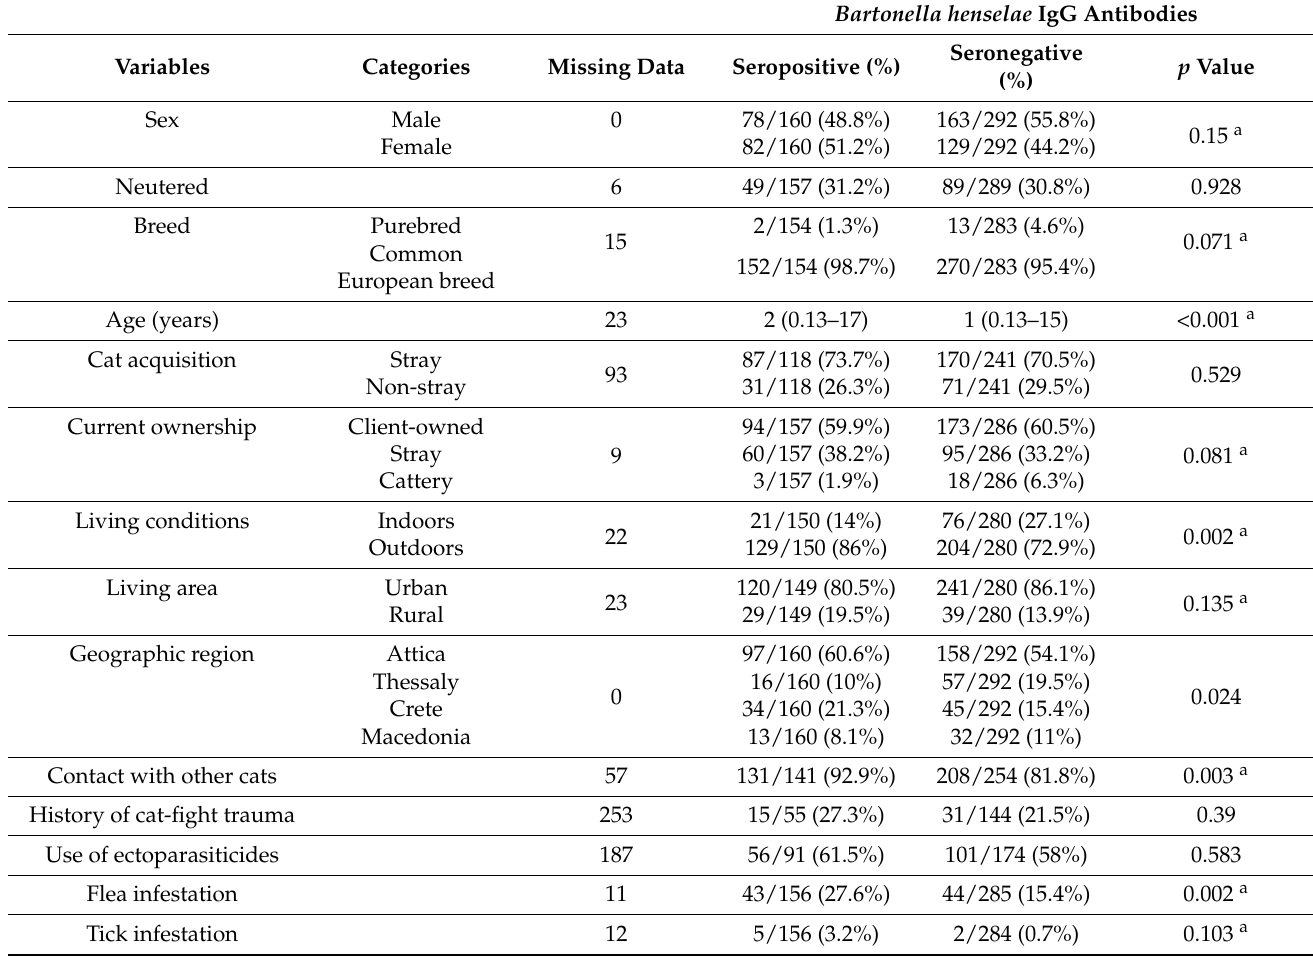
Table 2. Univariable associations between Bartonella henselae seropositivity and the signalment and historical data that were collected using a standardised questionnaire (Questionnaire S1).